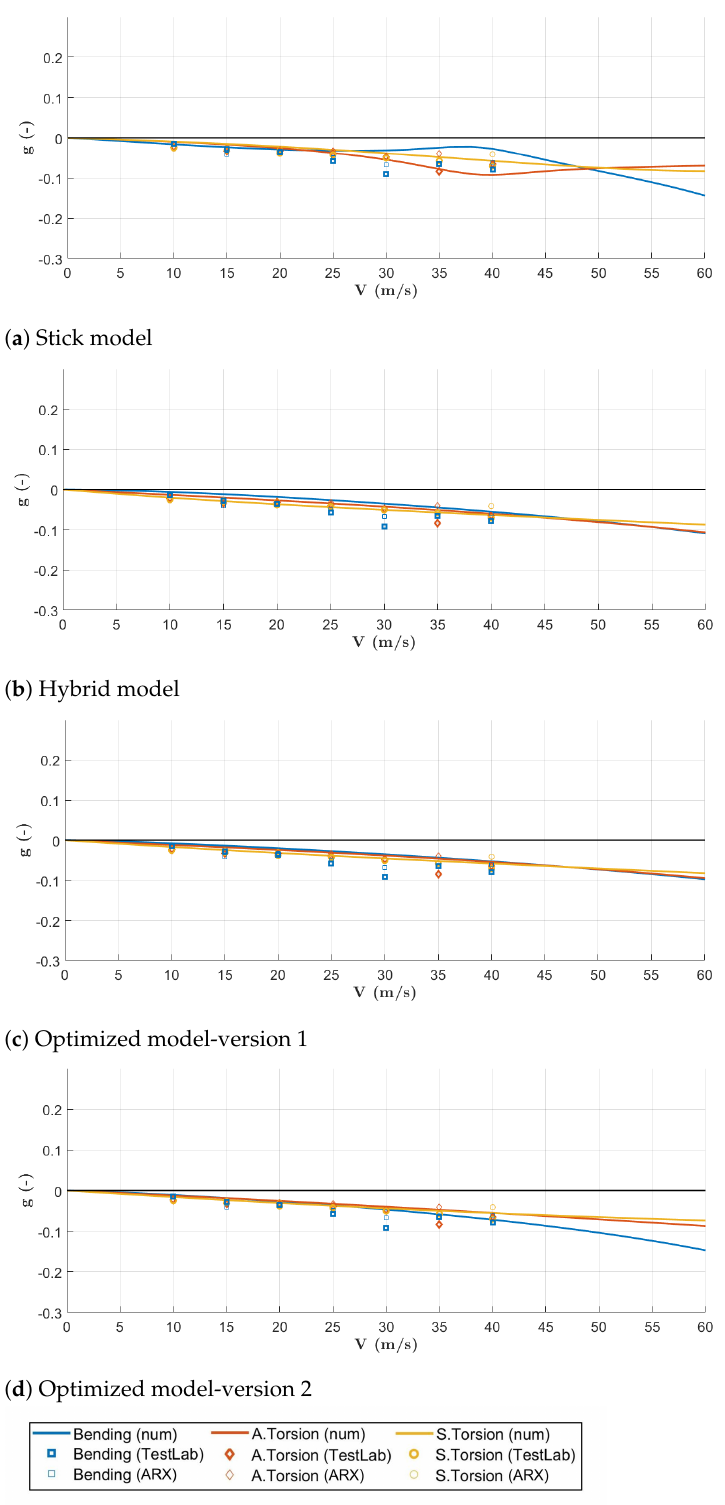
Figure 17. V − g plots of the mass-forward